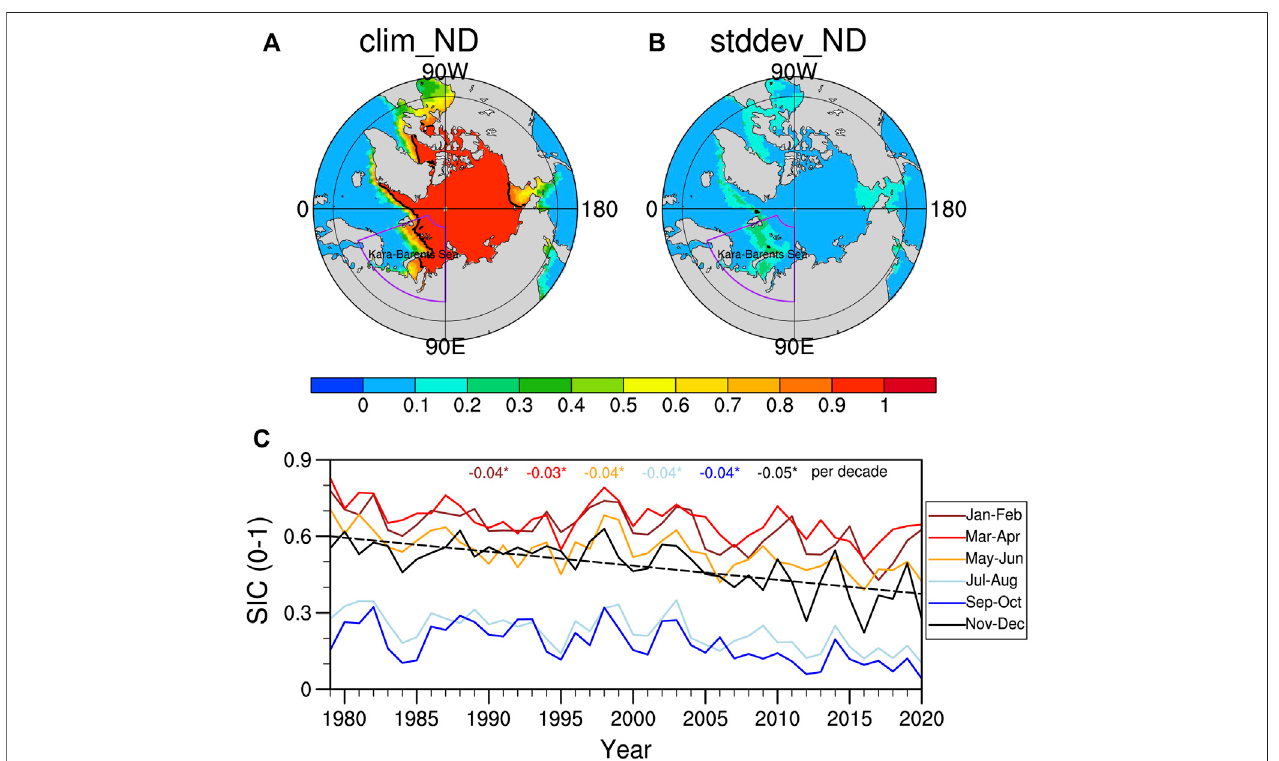
FIGURE1 | (A,B) Climatology and variability ofthe Arctic sea ice cover in November and December from 1979 to2020. The sector box marksBarents – Kara Seas wherethevariabilityisrelativelylarge(65 – 85 ° N,20 – 90 ° E). (C) Timeseries(coloredsolidcurves)oftheseaicecoverinBarents – KaraSeasforevery2 months.Thetrendof the sea ice cover is also printed, and the black lines especially mark the trend in November – December. An asterisk is added if the trend is signi fi cant at the 95% con fi dence